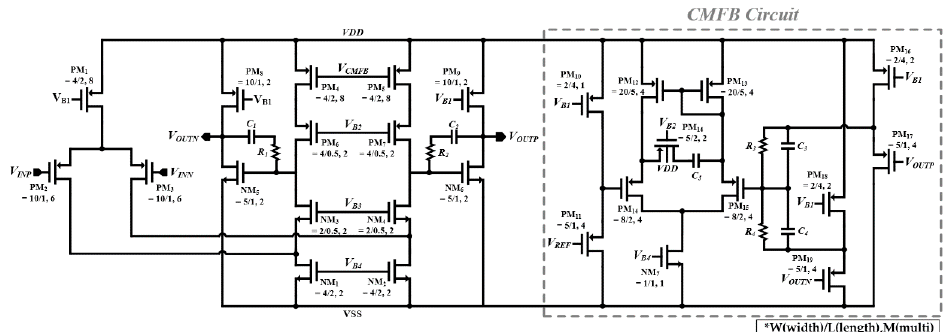
Figure 7. Schematic of the fully-differential amplifier.